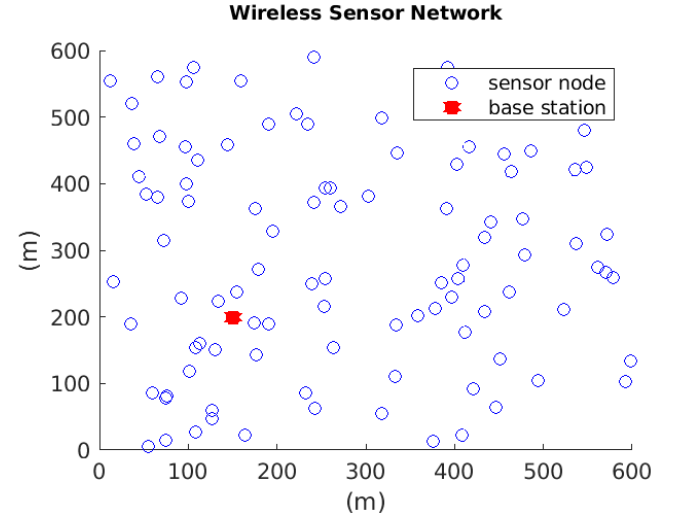
Figure 5. The initially deployed network.